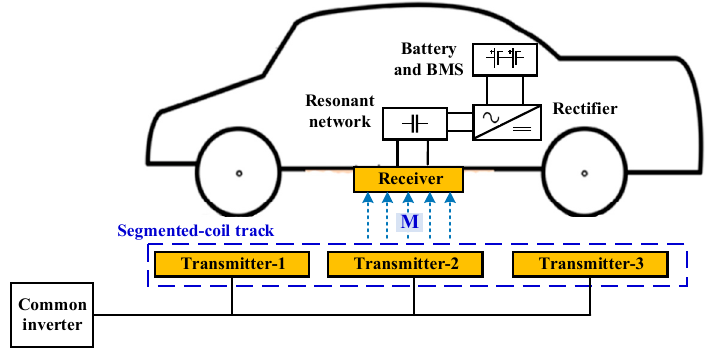
Figure 6. Simple configuration of segmented transmitter coil track for DIPT system.